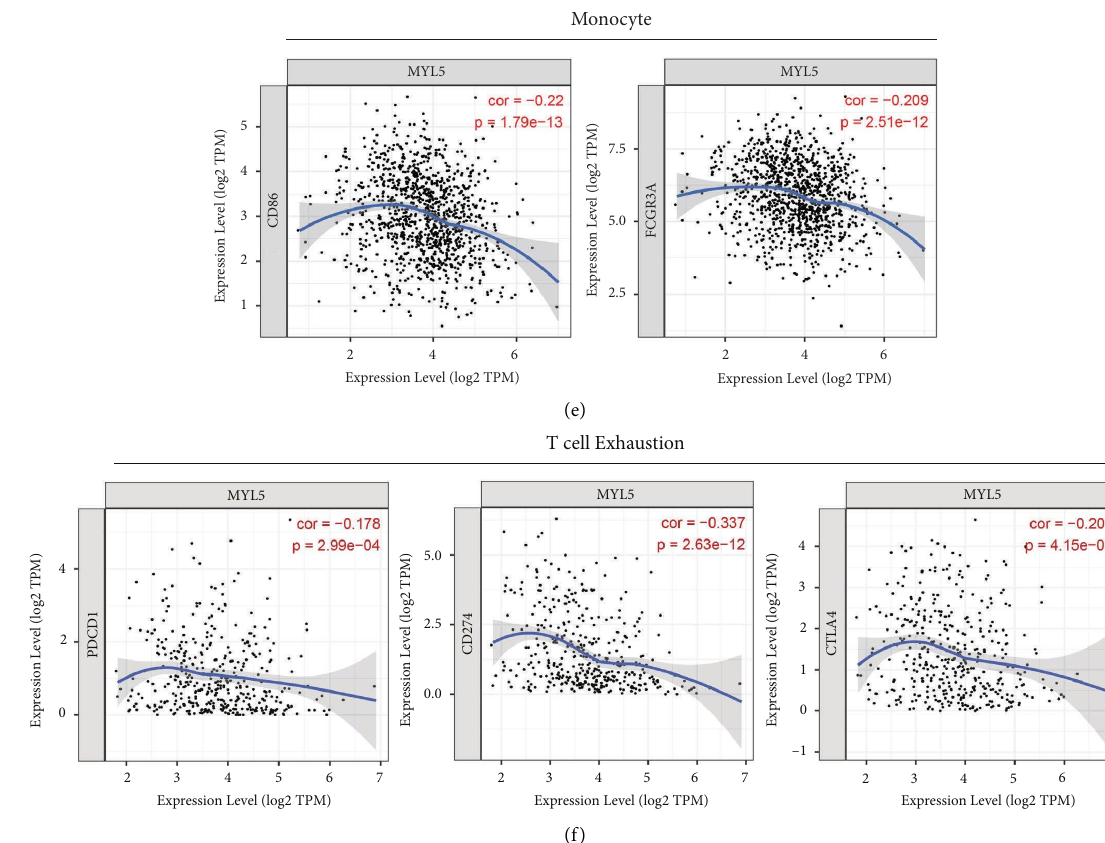
Figure 7: Correlation analysis between MYL5 expression and immunological marker set via using the TIMER tool in BRCA. Scatterplots of correlations between MYL5 expression and gene markers of B cell (a), M1 macrophage (b), M2 macrophage (c), tumor-associated macrophage (TAM) (d), monocytes (e), and T cell exhaustion (f) were displayed in breast cancer, without purity